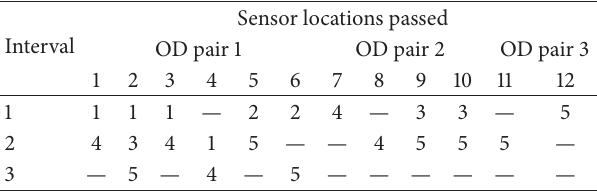
Table 1: Summary of sensor locations passed by probe vehicles.